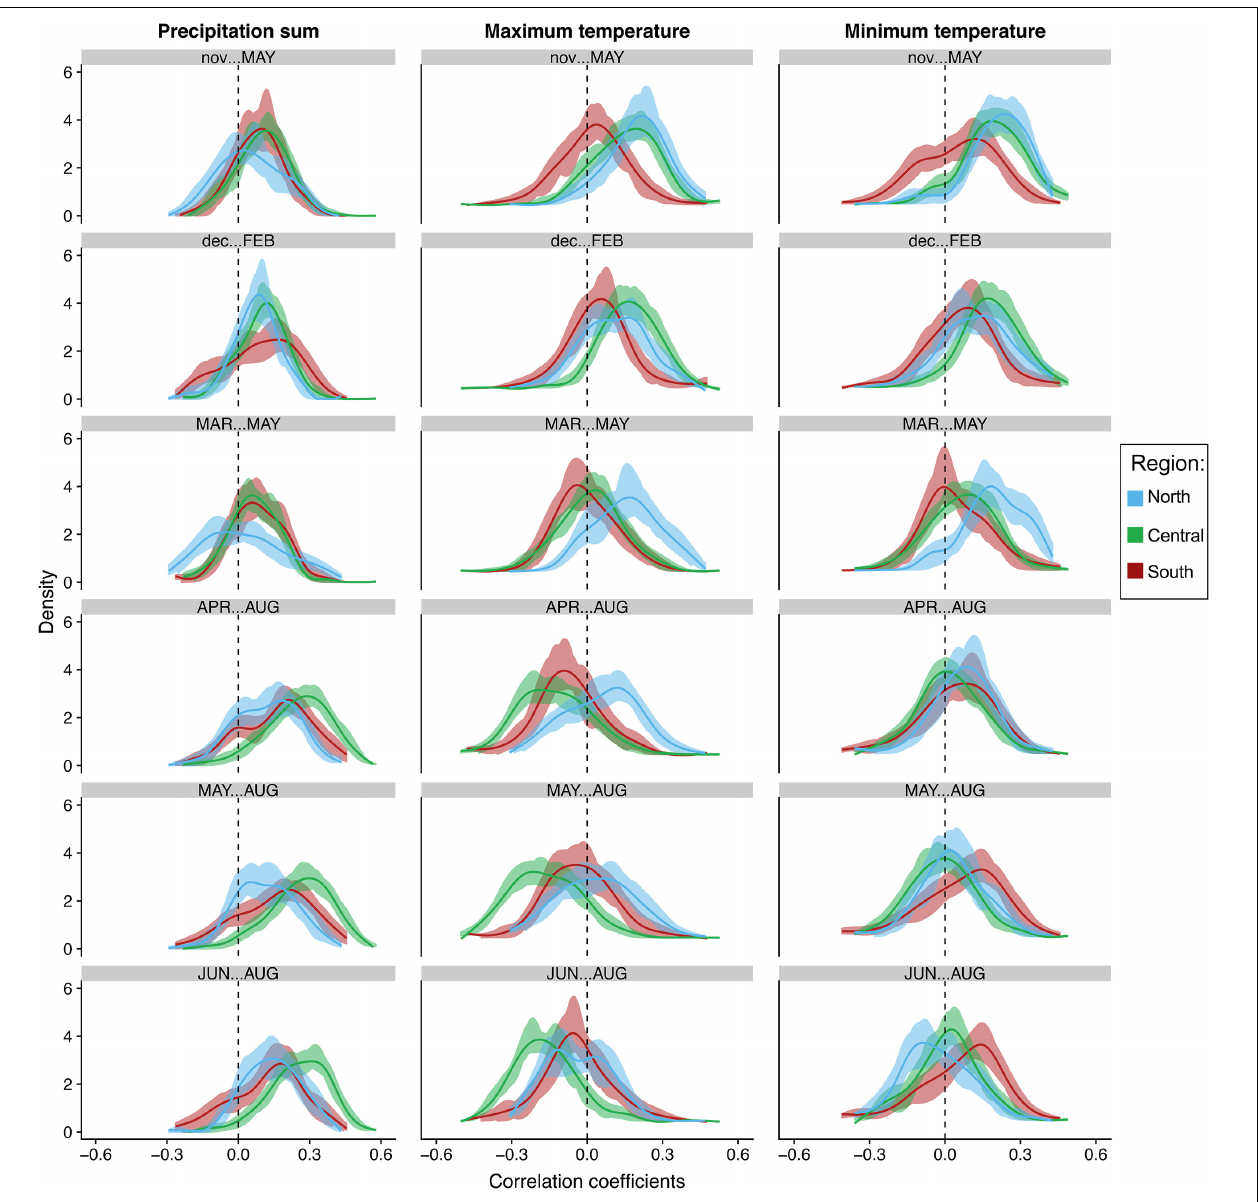
FIGURE 5 | Bootstrapped distributions of correlations of individual tree growth to seasonal total precipitation, average maximum and minimum temperatures at the regional level. Blue represents the northern end of our network (North), green represents the central region (Central), while brick red represents trees in the southern portion of our network (South). Solid lines represent the mean. Shading represents 100 bootstrapped iterations.